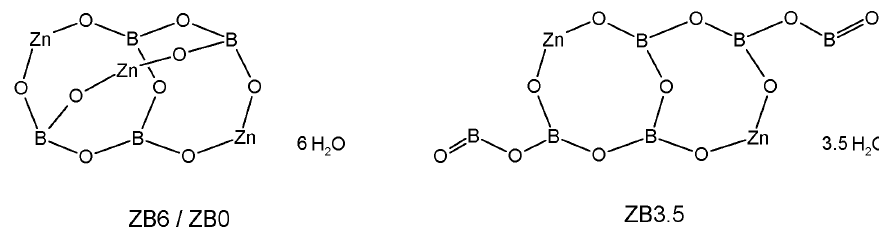
Figure 1. Structures of the tested zinc borates: 3ZnO·2B 2 O 3 ·6H 2 O (ZB6), 2ZnO·3B 2 O 3 ·3.5H 2 O (ZB3.5) and 3ZnO·2B 2 O 3 (ZB0).